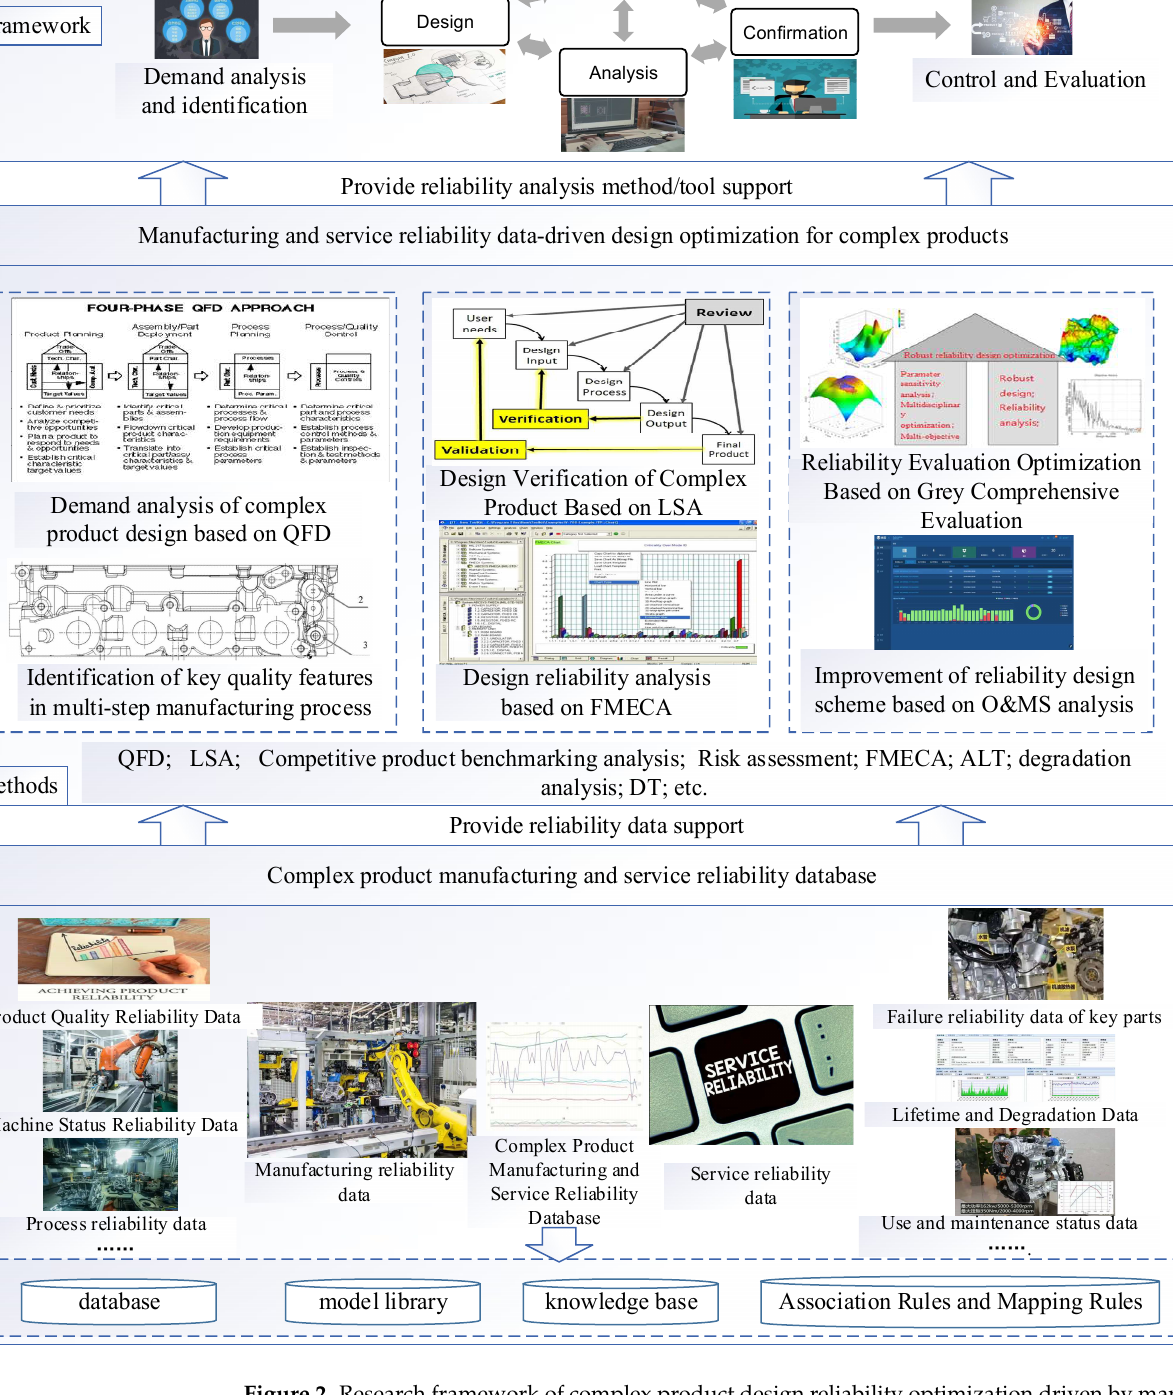
Figure 2. Research framework of complex product design reliability optimization driven by manufacturing and service reliability data.